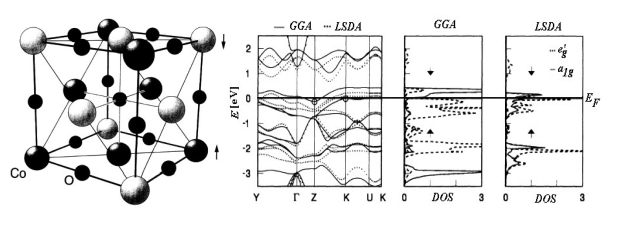
Left: the anti-ferromagnetic structure CoO; right: the band structure and the density of state (DOS) in LSDA and GGA approximations, respectively [53]. The upper and down arrows are associated with the spin orbital projections.